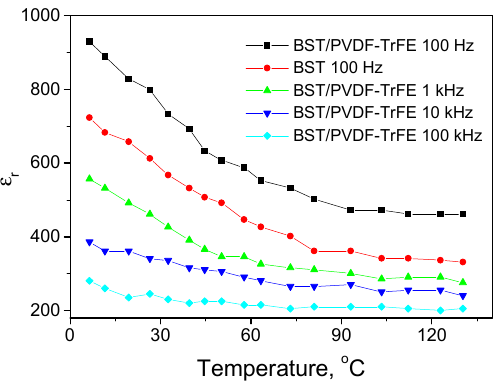
Figure 12. Variation of the permittivity with the temperature, frequency and composition of the functional film [36].